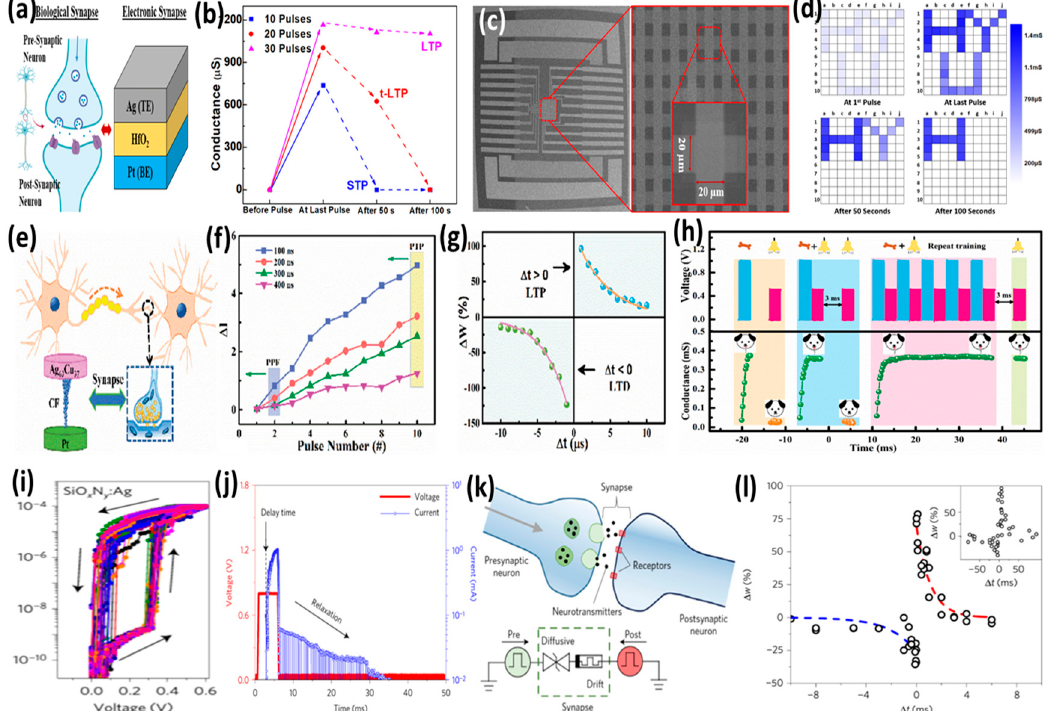
Figure 11. Emulation of essential biological synaptic functions with CBRAM devices. ( a ) The schematic images of the biological synapses and HfO 2 CBRAM-based artificial electronic synapses. ( b ) Demonstration of the transition of STP to LTP depending on the pulse stimulations in Ag/HfO 2 /Pt CBRAM devices. ( c ) Top-view SEM image of the Ag/HfO 2 /Pt crossbar array device. ( d ) Image memorization into the crossbar array demonstrating the STM and LTM behaviors of the brain with a transition from STM to LTM for higher memorization rehearsals. Reprinted from Ref. [17]. ( e ) A schematic representation of implementing an artificial synapse with a CBRAM device using Ag-Cu alloy as AE. The successful emulation of ( f ) SRDP and ( g ) STDP behaviors of the synapses in Ag 63 Cu 37 /HfO 2 /Pt device. ( h ) Experimental demonstration of Pavlov’s dog experiment. Reprinted from Ref. [40]. ( i ) The I-V characteristics of SiO x N y :Ag-based diffusive memristors presenting highly repeatable TS. ( j ) The delay, SET and self-relaxation behavior of the diffusive memristor. ( k ) The combination of the diffusive memristor with a drift memristor for emulation of synaptic functions. ( l ) The successful emulation of the STDP learning rules by the combined diffusive and drift memristors. Reprinted from Ref. [51].